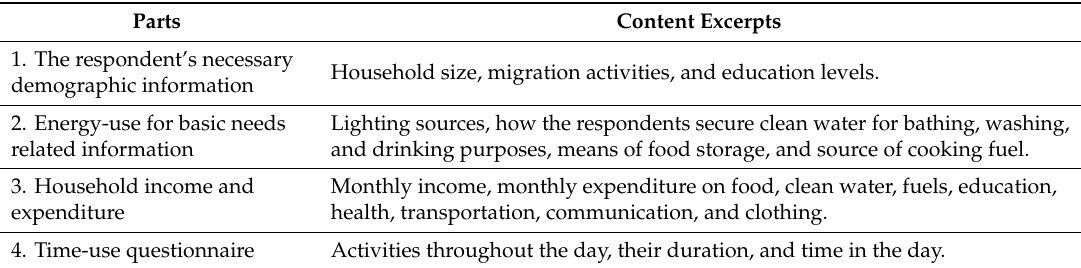
Table 2. Structure of survey